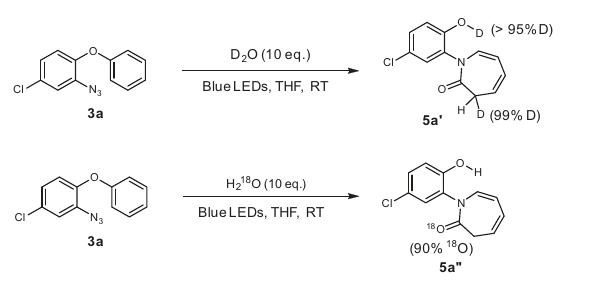
Fig.5|Deuteriumand 18 Olabelingexperiments. TheH/Dratiosweredetermined by 1 H NMR spectroscopy with trimethoxybenzene as the internal standard. The incorporation of the 18 O atom was detected by MS and a second carbonyl peak in the 13 C NMR spectrum.